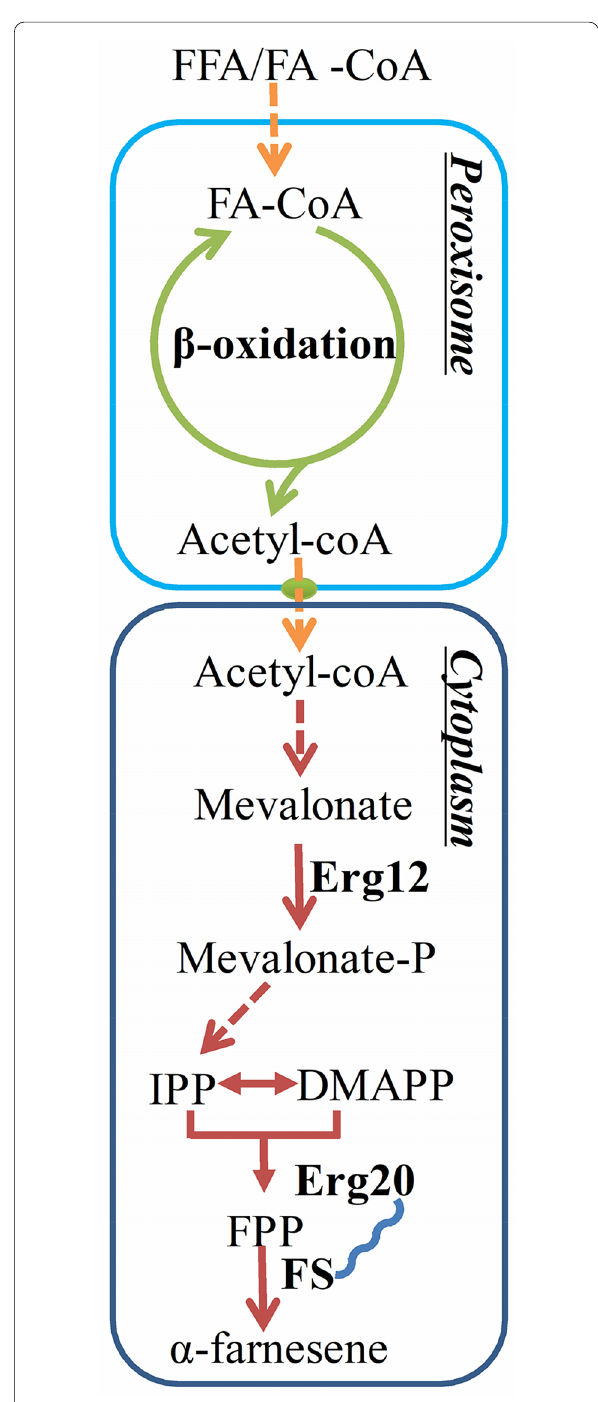
Fig. 1 Metabolic pathway of α-farnesene synthesis from lipid substrate in Y. lipolytica . Lipid was activated to FA-CoA, which converts to acetyl-CoA through β-oxidation. Acetyl-CoA was transported to cytoplasm and α-farnesene synthesized via the MVA pathway. Here, Erg20 and FS were used by a linker with GGGS amino acid sequence. FFA free fatty acid; FA-CoA fatty acid-CoA; Black bold font, overexpression of